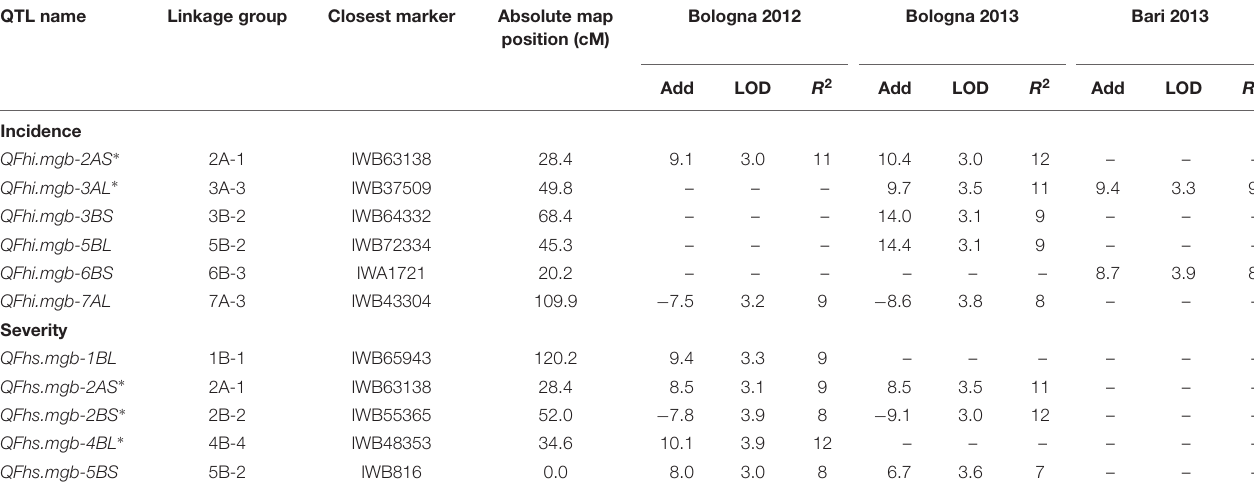
TABLE 5 | List of QTL detected for FHB incidence and severity by inclusive composite interval mapping (ICIM) in the durum wheat RIL population derived from the cross between FHB-resistant 02-5B-318 line and FHB-susceptible cv. Saragolla; for each marker, one of the co-migrating loci at the same map position is reported.